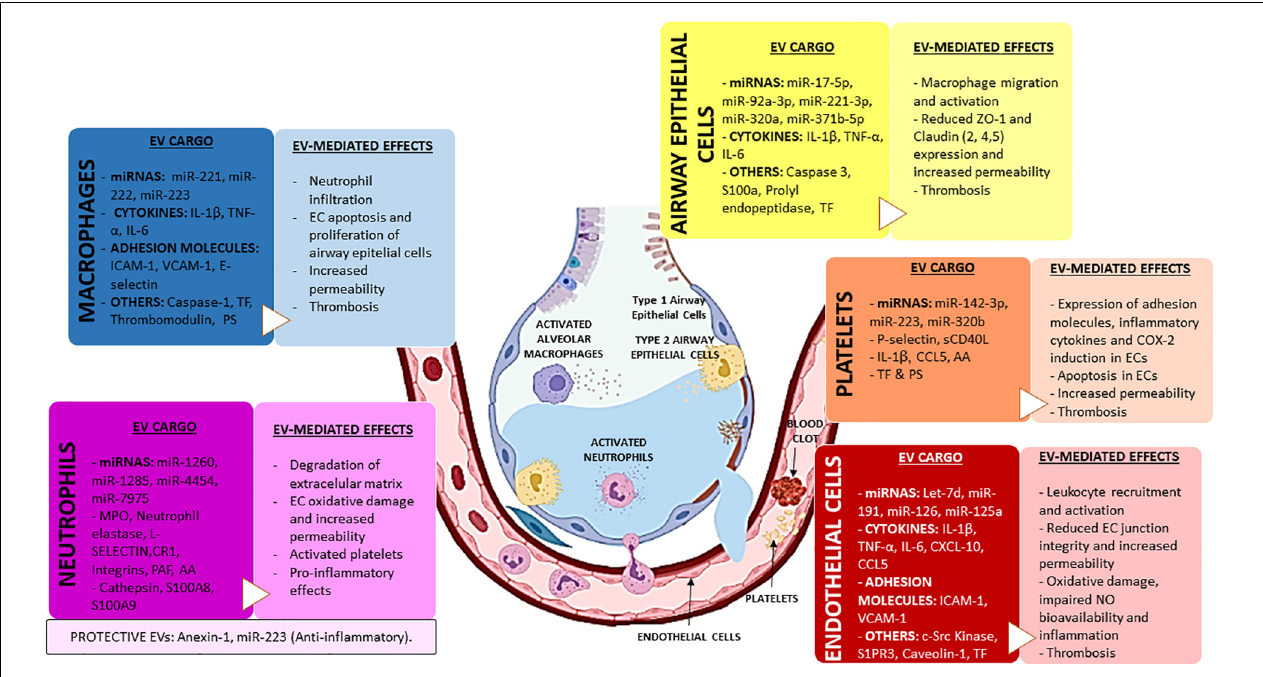
FIGURE 1 | Extracellular vesicles (EVs) involved in the pathophysiology of acute respiratory distress syndrome (ARDS). Schematic representation of an injured alveolus in ARDS and the potential role of specific EVs based on their parent cell and their cargo. AA, Arachidonic acid; CCL5, C-C motif chemokine 5 (also known as RANTES); CR1, Complement Receptor-1; CXCL-10, C-X-C motif chemokine ligand 10; EC, endothelial cells; IL, interleukin; ICAM-1, intercellular adhesion molecule-1; miR, micro ribonucleic acid; NO, nitric oxide; PAF, platelet activating factor; PS, phosphatidylserine; S100A8, S100 calcium-binding protein A8; S100A9,